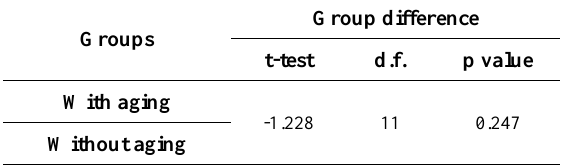
Table 1: T-test of the SBS of PEEK retainer with and without aging